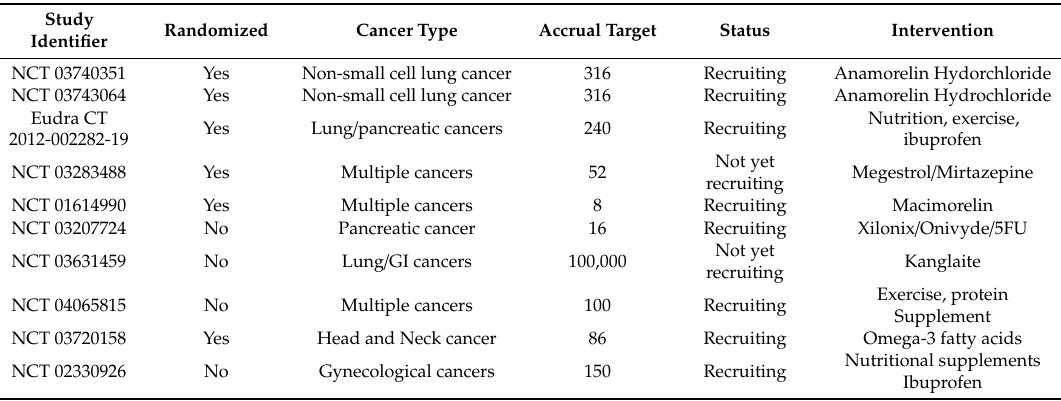
Table 1. Current Interventional Cachexia